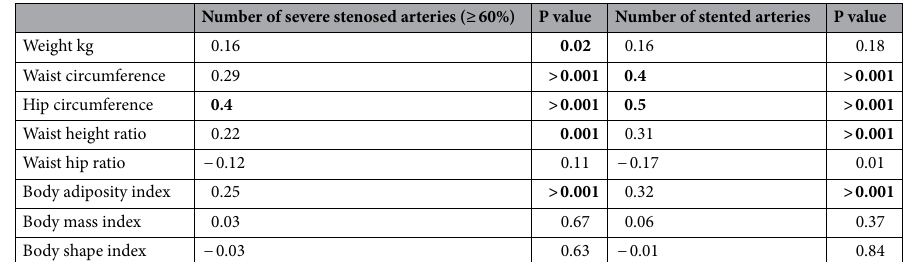
Number of severe stenosed arteries (≥ 60%) P value Number of stented arteries P value